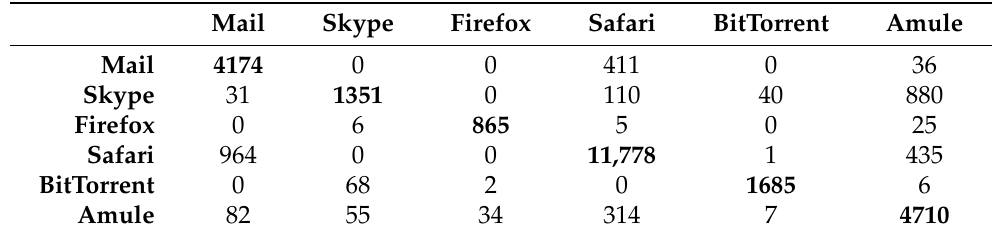
Table 7. SVM: confusion matrix (UniBS, composite— H =